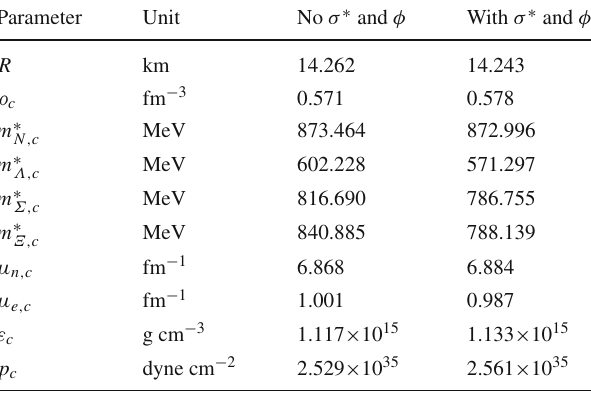
ofthenucleusdecreasesby0.05%from m ∗